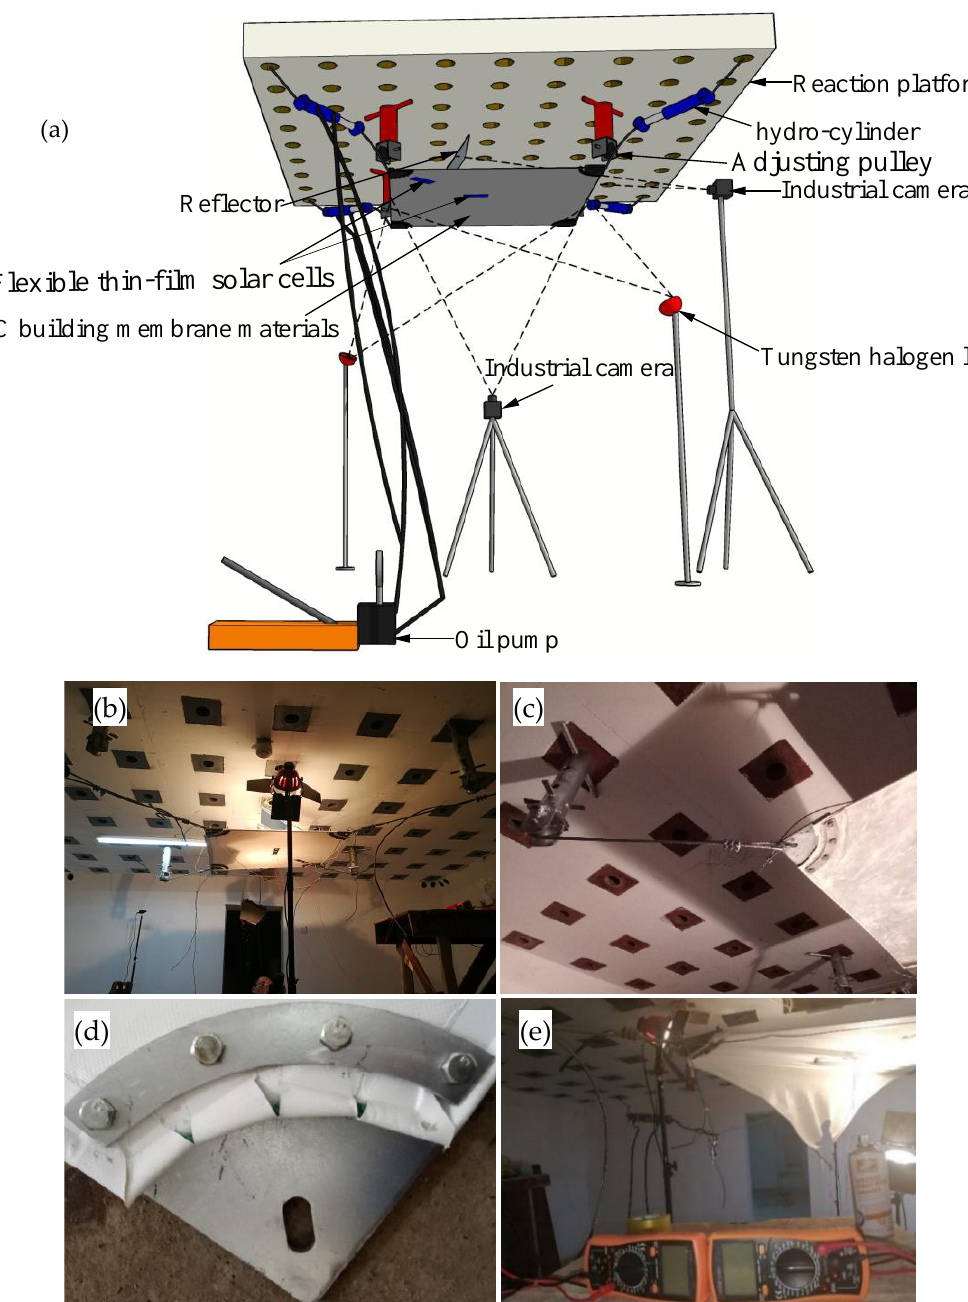
Figure 3. The biaxial loading device of composite structure: ( a ) three-dimensional schematic diagram of the device, ( b ) overall test process, ( c ) pipe and pulley support, ( d ) connection between steel plate clamp and membrane material, and ( e ) voltage test device.